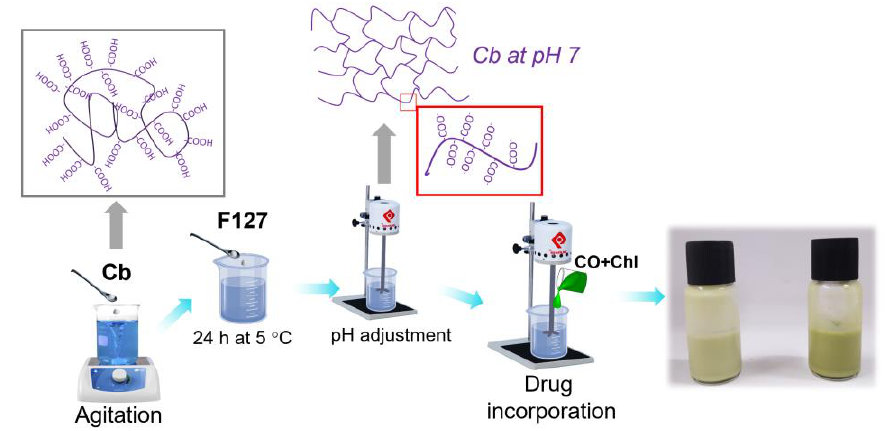
Table 1. Dermatological gel composition for 100